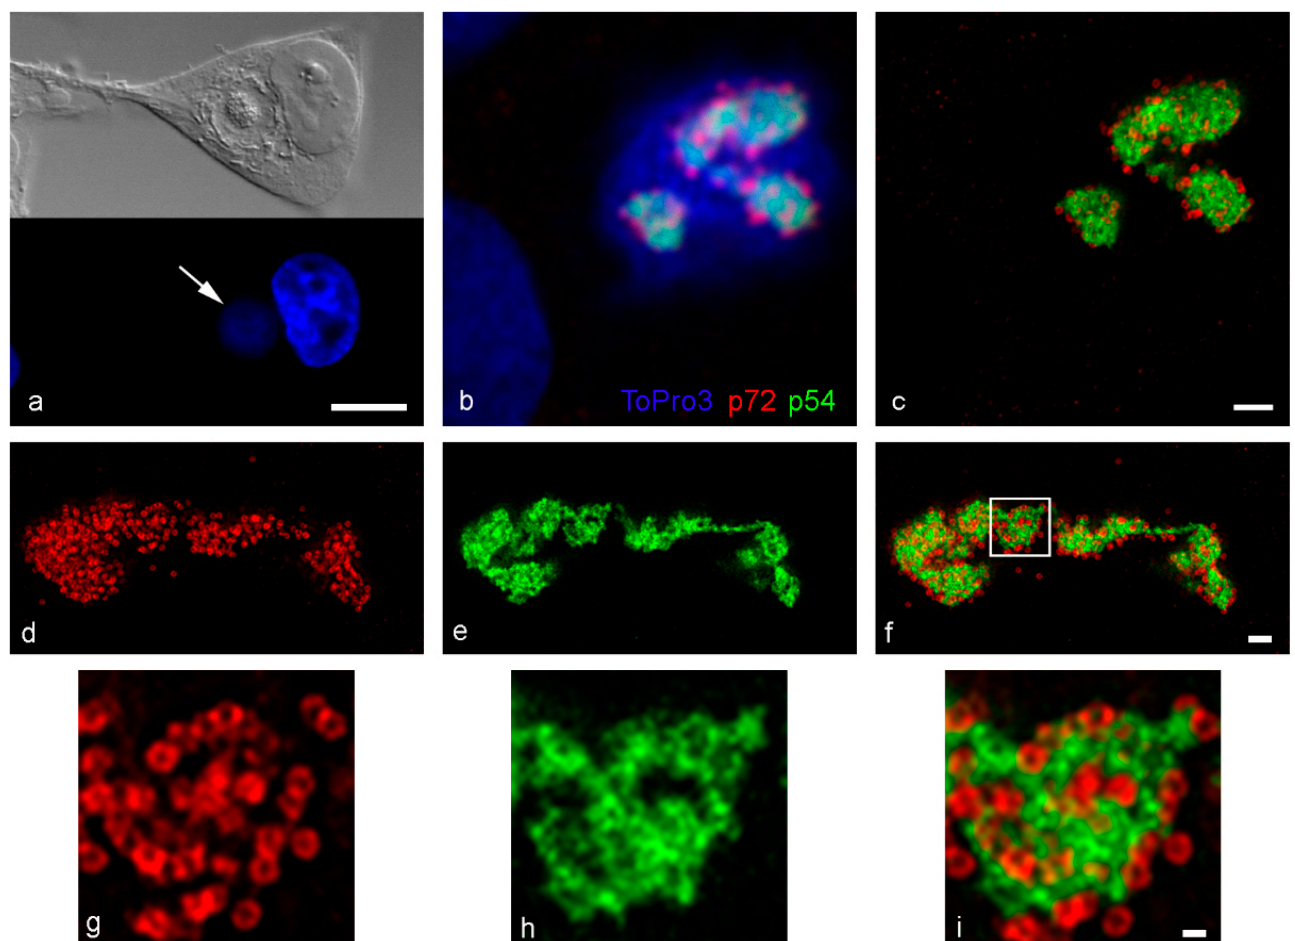
Figure 1. ASFV infected Vero cells by confocal and STED microscopy, fixed at 16–18 hpi. ( a ) DIC (top) imaging shows 18 hpi viral factories are distinct perinuclear structures containing viral DNA (DAPI, bottom, arrow). ( b ) p54 (intermediate protein, RB7 antibody) and p72 (late protein, 17LD3 antibody) localize to the viral factory at 16 hpi by confocal. ( c ) STED imaging of the same cell reveals more detail. ( d , g ) STED imaging of the major capsid protein p72 clearly reveals capsid rings. ( e , h ) STED imaging of p54 details an intricate reticular network not previously seen by confocal microscopy. ( f , i ) Overlay of p72 and p54 labelling confirms the close association between the proteins, but there is no co-localization. The capsid rings sit around the protein network. Scale bars: a = 10 μ m, c, f = 1 μ m, i = 200 nm.